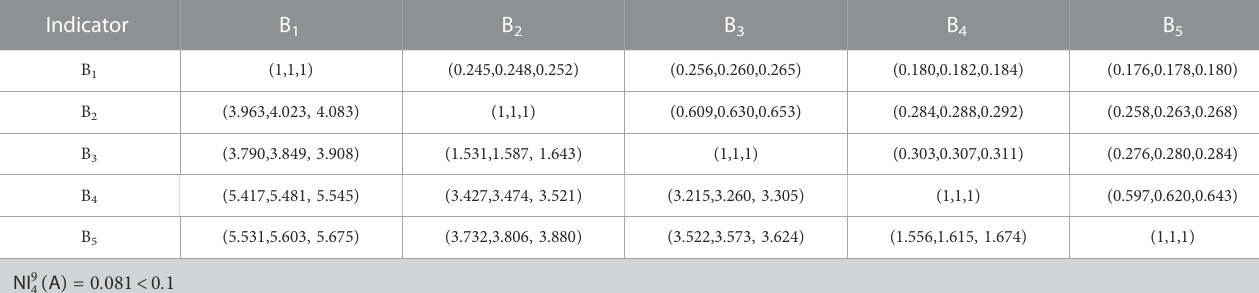
TABLE 6 Pairwise comparison matrix of civil construction factor layer (MCS-AHP).